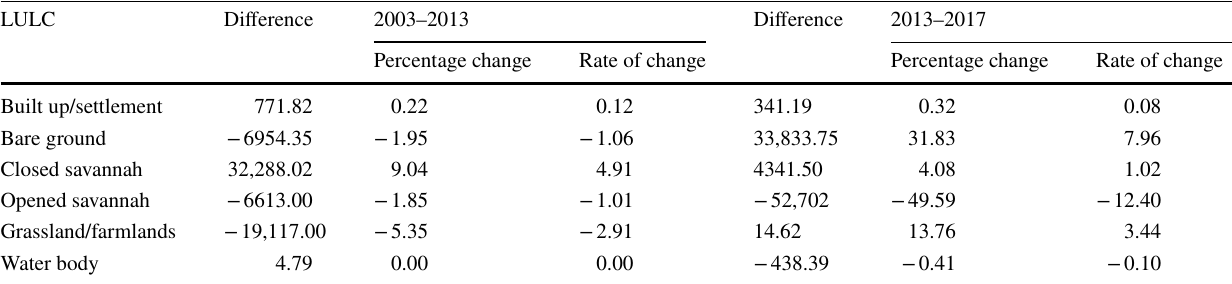
Table 2 LULCC between 2003 and 2013 and between 2013 and 2017 in the Nawuni Catchment LULC